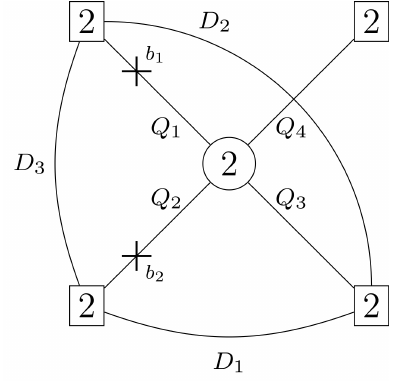
Figure 3 . Quiver diagram for the T 2